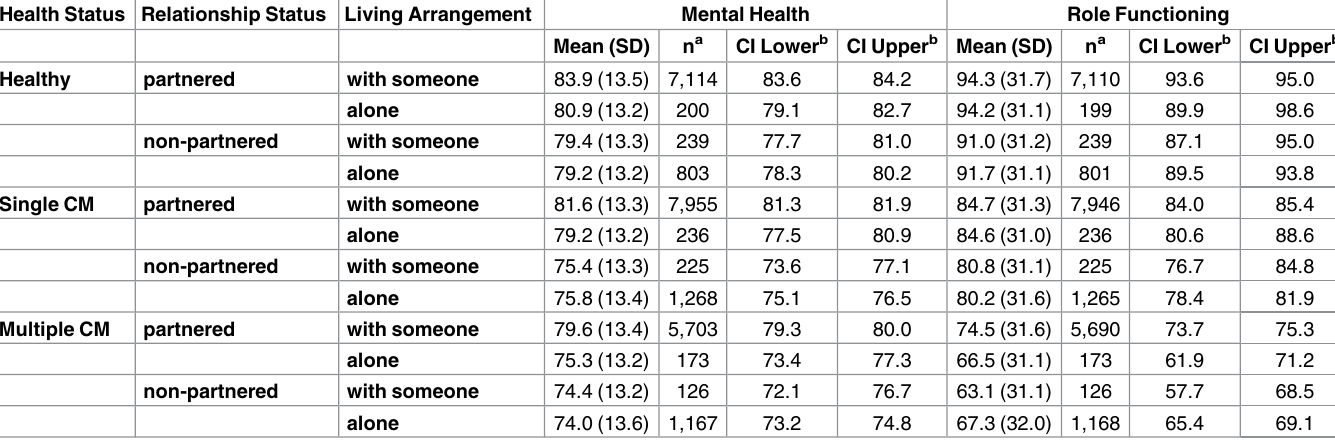
Table 3. Descriptivestatistics for the outcomes of mental health and role functioning.